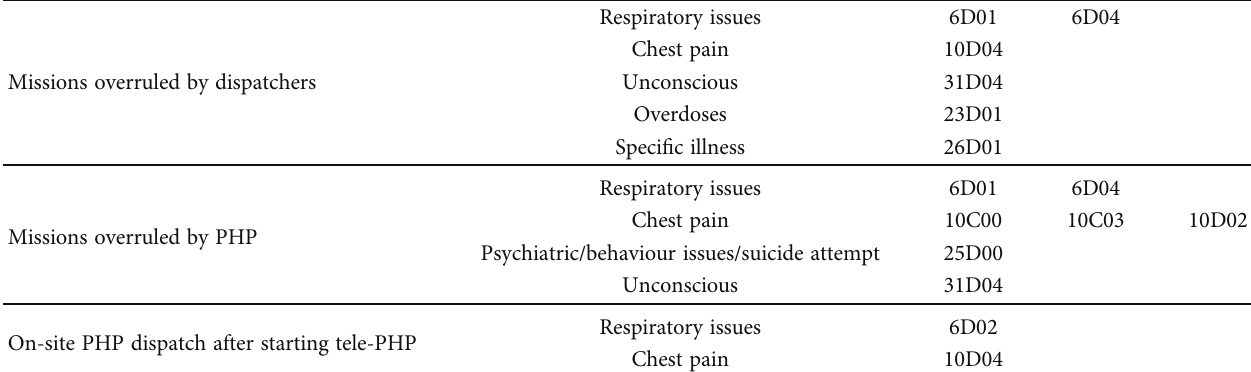
Table 3: Advanced Medical Priority Dispatch System (AMPDS) codes of remote prehospital emergency physician support through telemedicine (tele-PHP) missions overruled by dispatcher and PHP and codes of tele-PHP missions required PHP once paramedics were on site.